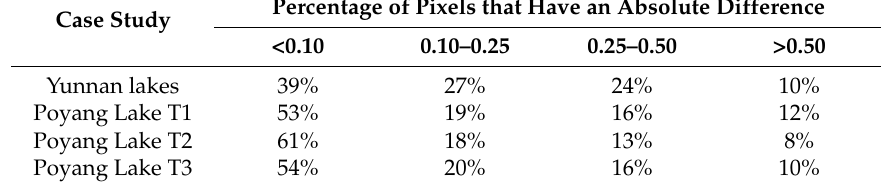
Table 2. Percentage of mixed pixels with four levels of absolute difference.